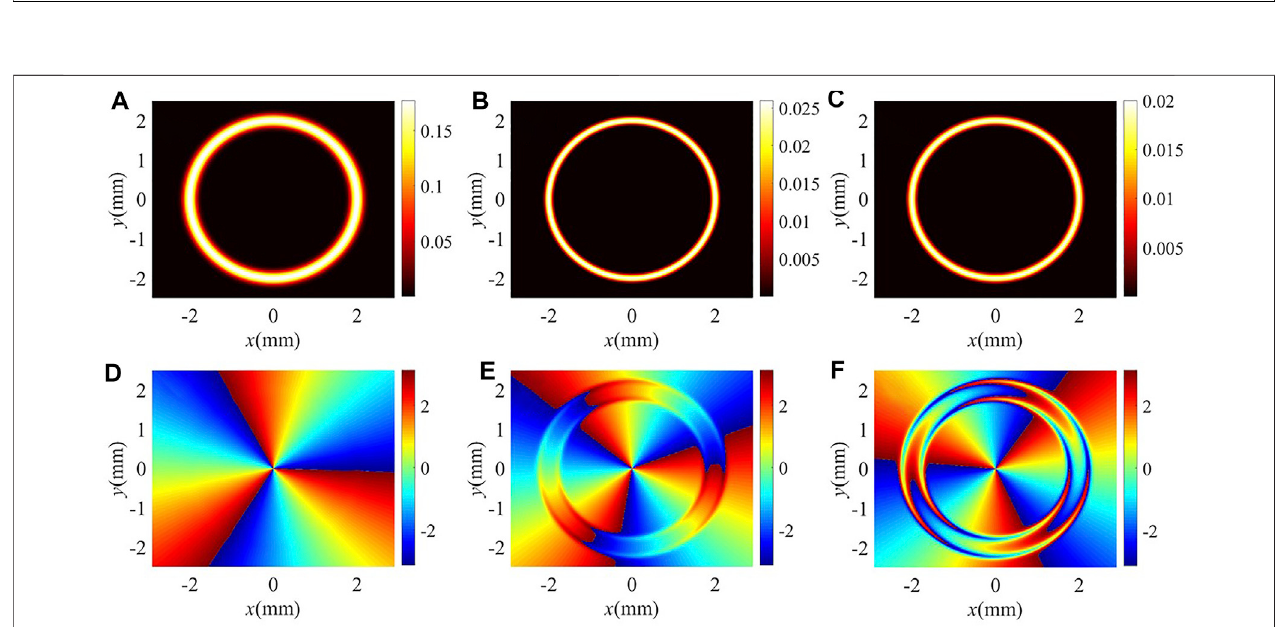
FIGURE 4 | (A – C) Intensity and (D – F) phase pro fi les of the FWM fi eld for different probe detuning Δ p : (A,D) Δ p = − 4 meV; (B,E) Δ p = 4 meV; (C,F) Δ p = 8 meV. Other parameters are the same as in Figure 2C .